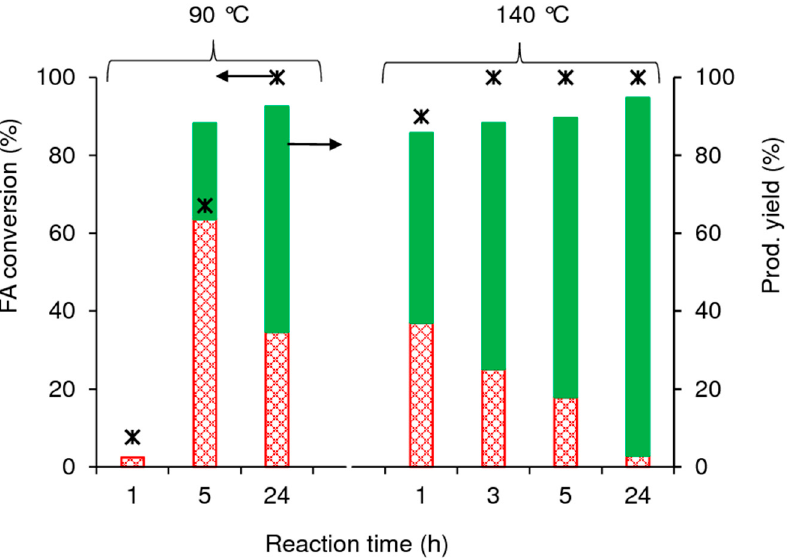
Figure 10. Influence of the reaction temperature and time on FA conversion (*) and the EMF (crossed bars) and EL (solid green bars) yields for the FA/ethanol reaction in the presence of 1 .